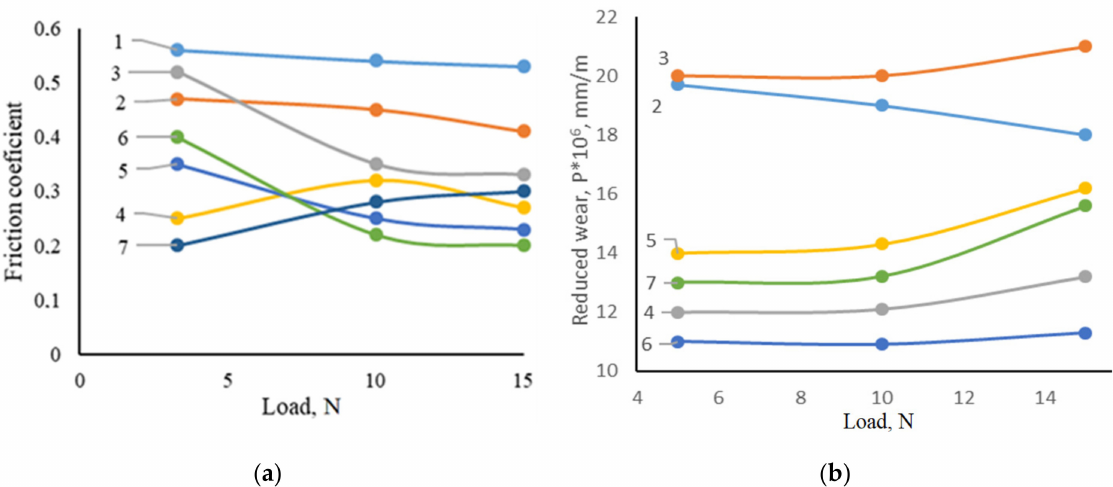
Figure 8. Dependence of friction coefficient ( a ) and reduced wear ( b ) on slip load AISI W1-7 of steel (1), AISI W1-7 chromium steel (2), AISI W1-7 nitrous steel (3), titanium aluminized with Cr 7 C 3 , Cr 23 C 6 layer (4), titanium aluminized (5), titanium aluminizing after nitriding (6), titanium aluminizing with TiN (7). The sliding speed is 10 m/s; the reduced wear of AISI W1-7 steel (HRC 62) at loads of 3.0, 10.0, and 15.0 N are equal to 43.0, 53.0, and 59.0, respectively; the sliding speed is 10